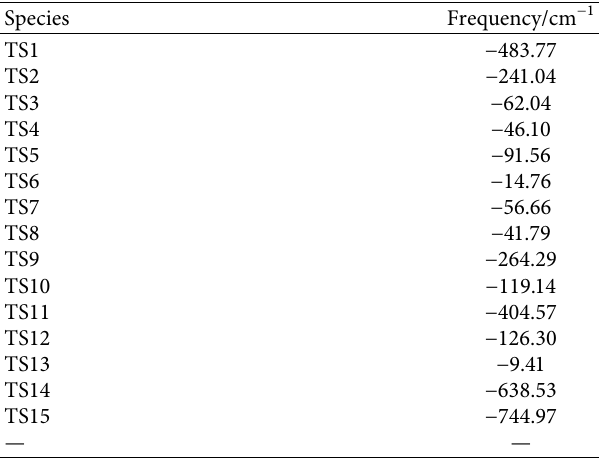
Table 2: Imaginary frequency of transition state in the reaction between O 2 and Fe 4 S 4 clusters.